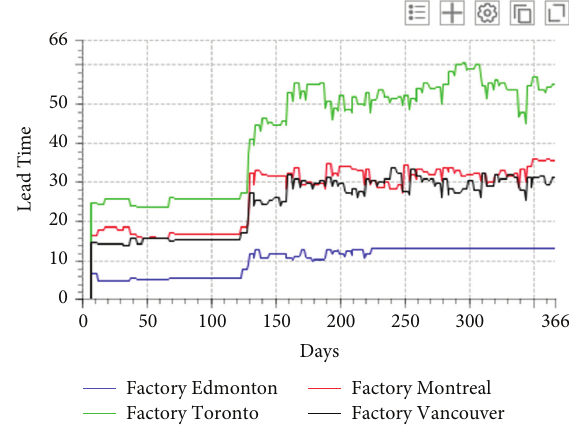
Figure 8: Lead times for different factories.